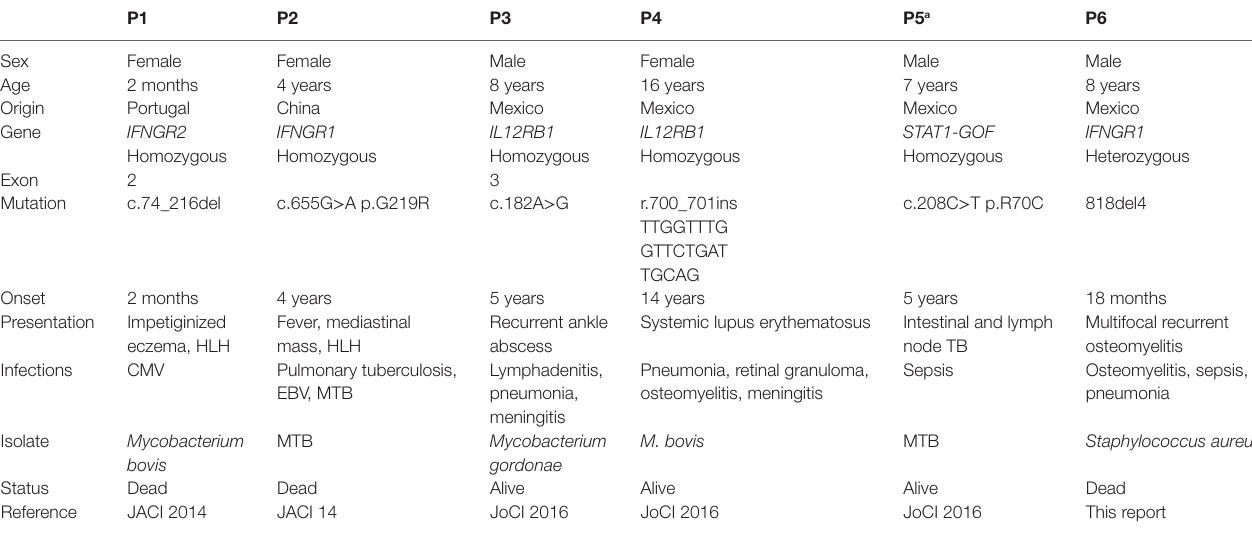
taBLe 1 | Clinical and genetic features of six patients with MsMD and